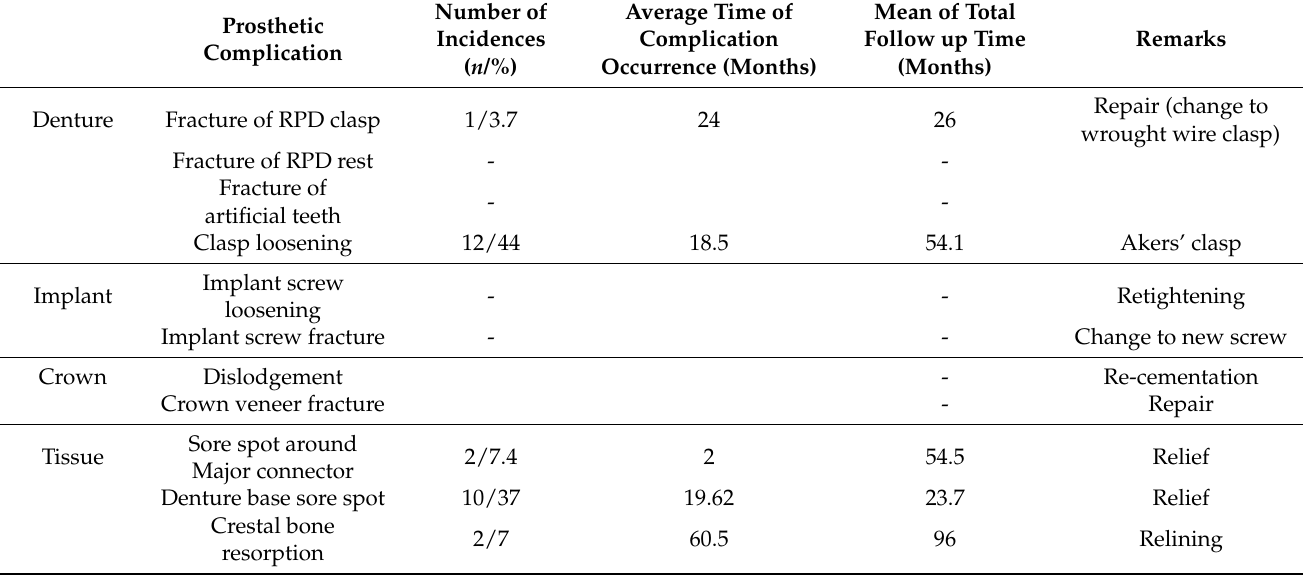
Figure 5. Esthetic and Functional improvement by VAS according to treatment modality (IC-RPD vs. IOD). ( a ) The OD group showed higher measured values by VAS in esthetic improvement ( p = 0.024). ( b ) The IC-RPD group showed a significantly higher value in functional improvement ( p < 0.001). Green dot indicated only one patient with VAS value of 1.5 after delivery of IOD. Table 9. Complications in IC-RPDs with implant